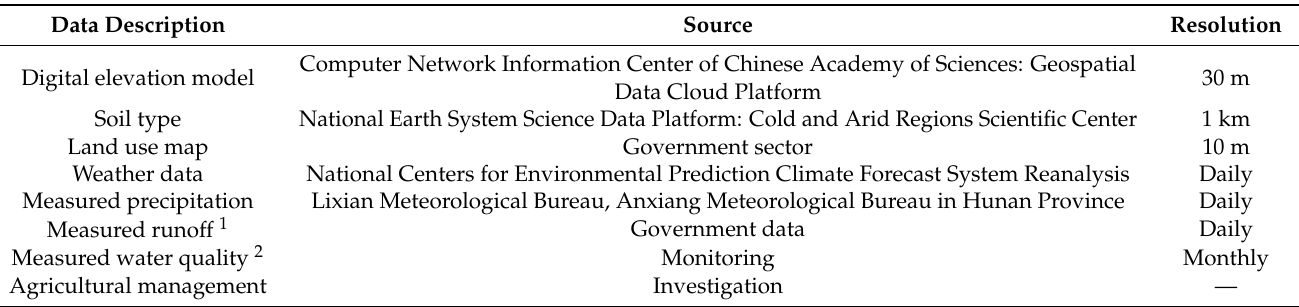
Table 1. Main input data of SWAT model of Maoli Lake